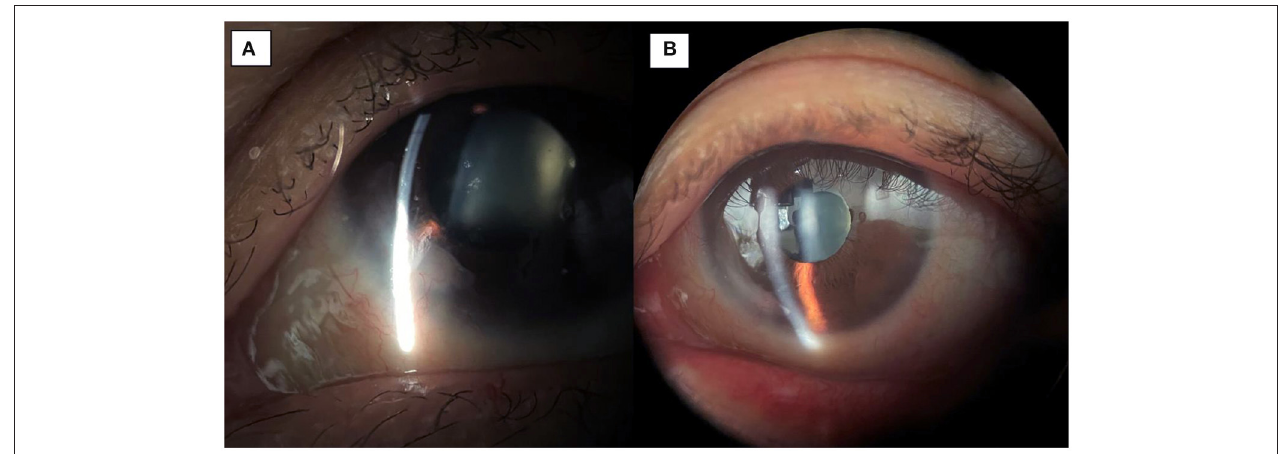
FIGURE 2 | (A) 1-month post-op image showing integration of the amniotic membrane patch in the inferonasal corneal stroma. (B) 3-month post-op image demonstrating smooth integration and an uninflamed left